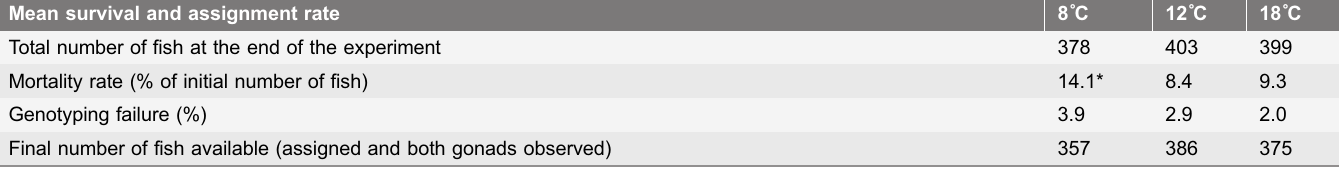
Table 1. Overall mean survival rates and assignment success according to temperature treatments in experiment A. Mean survival and assignment rate